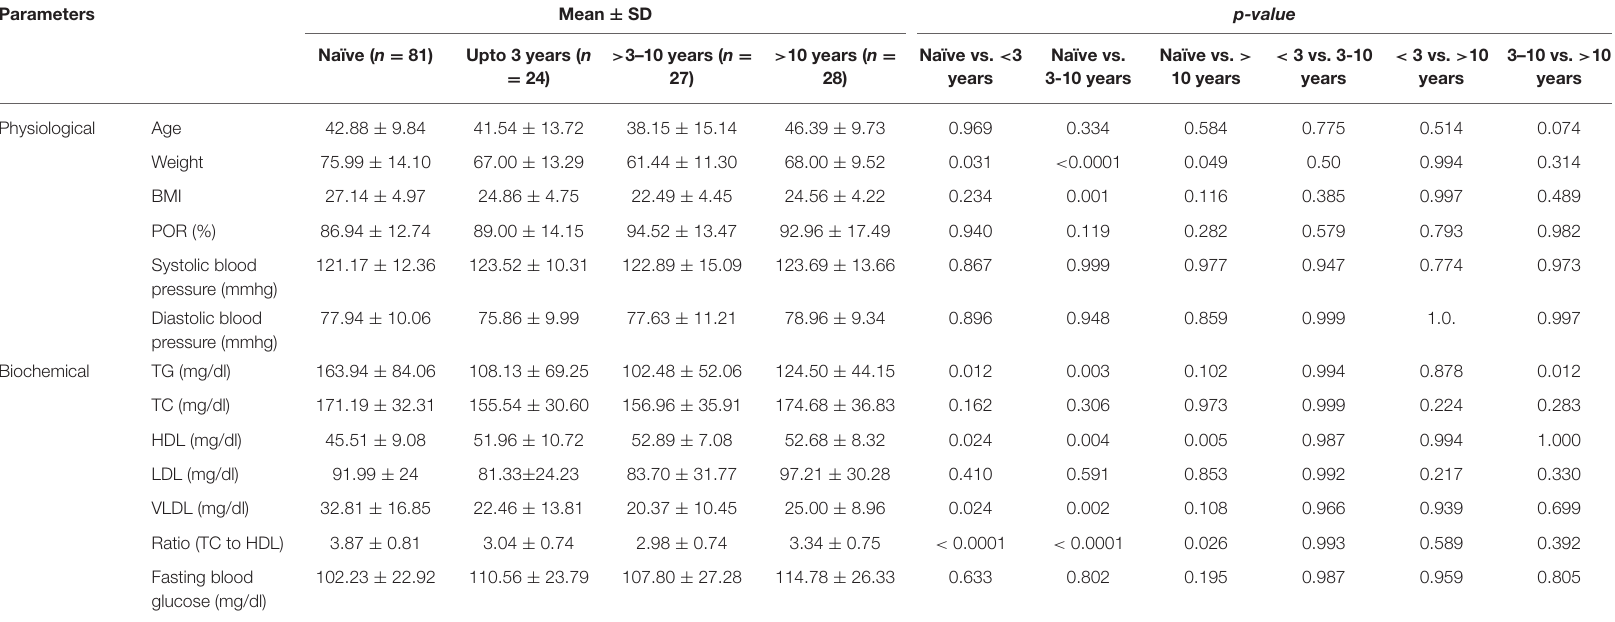
TABLE 2 | Comparative analysis (means with standard deviation) of physiological and biochemical factors in different groups based on their experience in yogic practices with naïve participants.